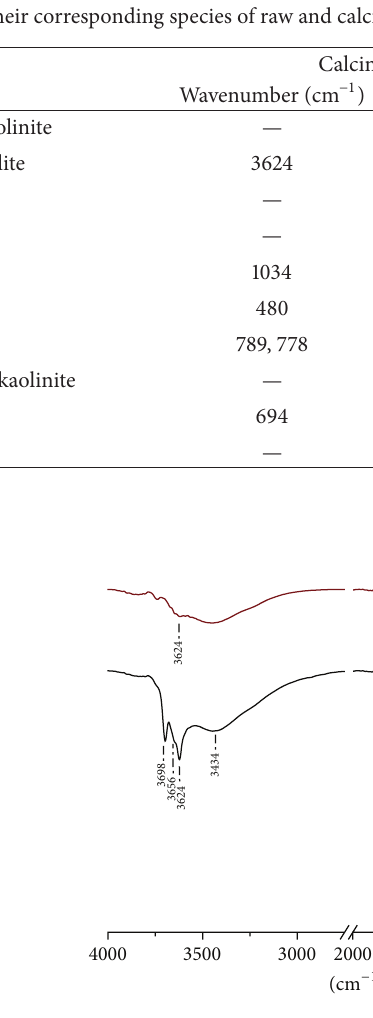
Figure 2: FTIR spectra of raw and calcined